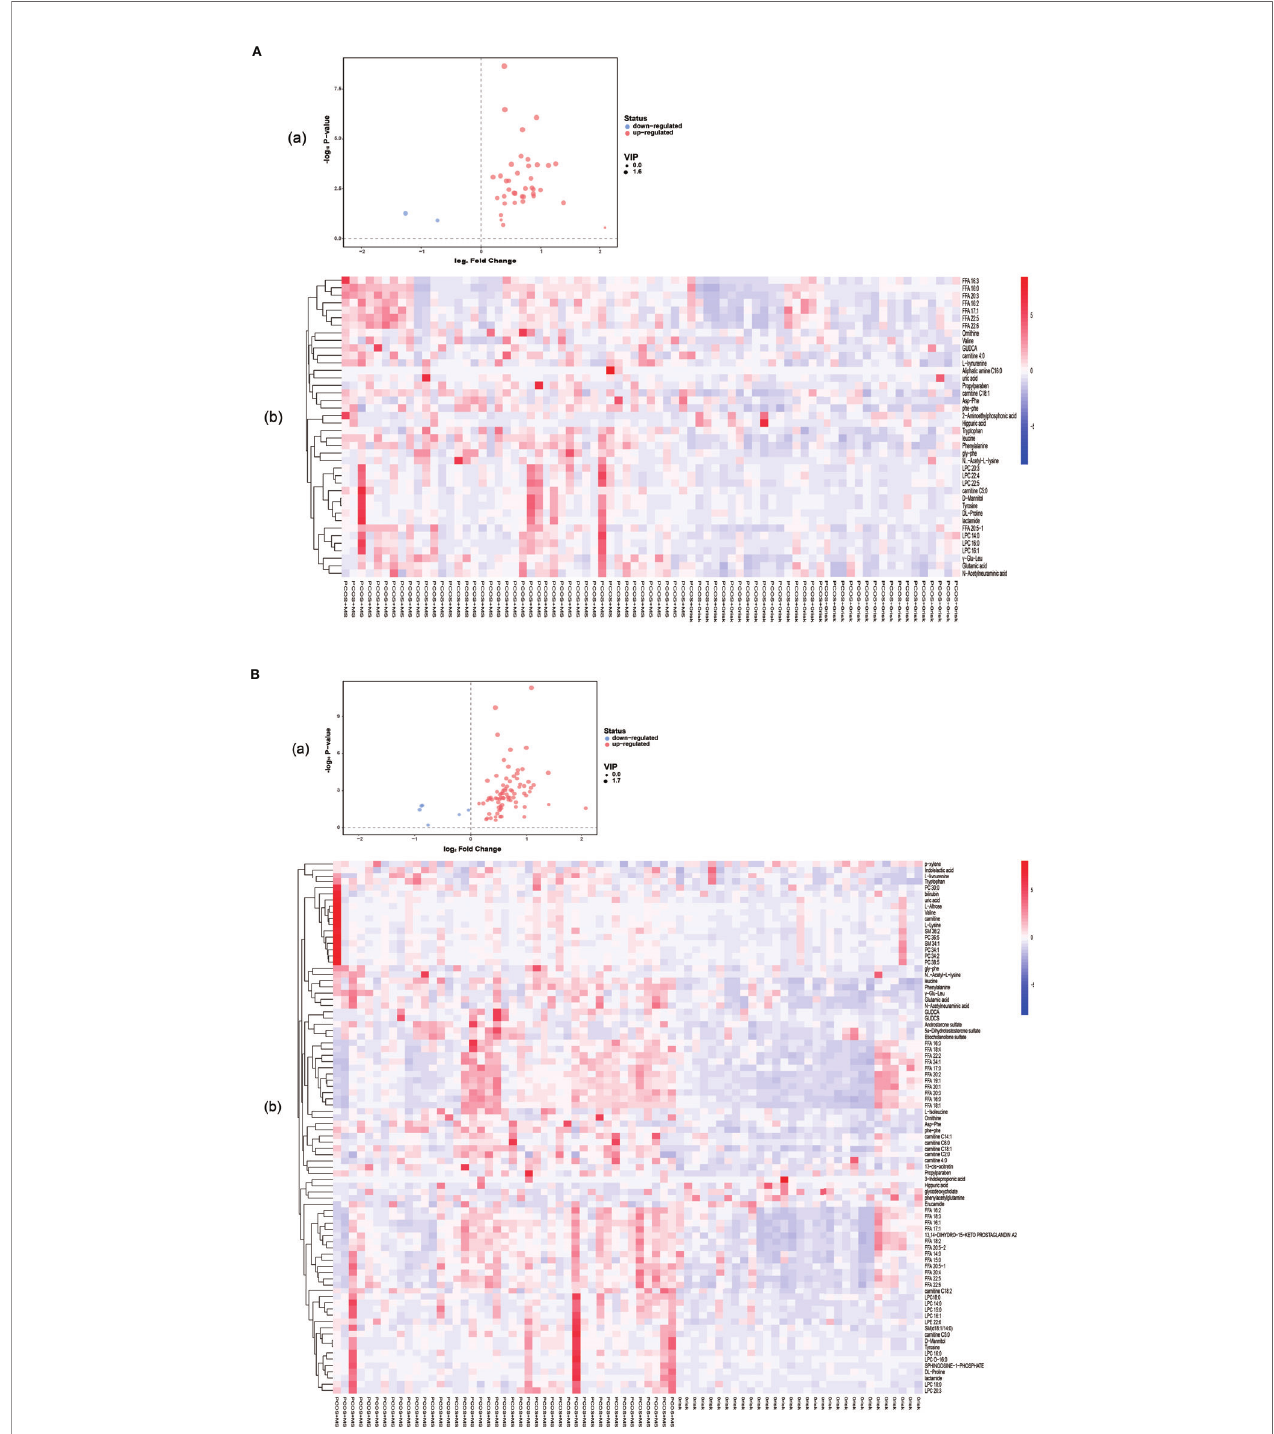
FIGURE 4 | (A) Volcano plot (a) and heatmap of hierarchical clustering analysis (b) for group PCOS vs . PCOS-MS. (B) Volcano plot (a) and heatmap of hierarchical clustering analysis (b) for group HC vs. PCOS-MS The Volcano map shows differential metabolites in PCOS vs. PCOS-MS and HC vs . PCOS-MS, with the abscissa representing log2 (fold change) and the ordinate representing − log10 (P value). Metabolites which changed signi fi cantly (VIP > 1, P < 0.05) are highlighted in red (for increased) and blue (for decreased). Heatmaps can visually show the variation of differential metabolites via pairwise contrasts. Each small square represents a metabolite, and the color indicates the amount of metabolite, with the higher the amount, the darker the color (red is the high expression, blue is the low expression). The tree graph on the left shows the results of cluster analysis of the metabolite variation trend in the two groups of